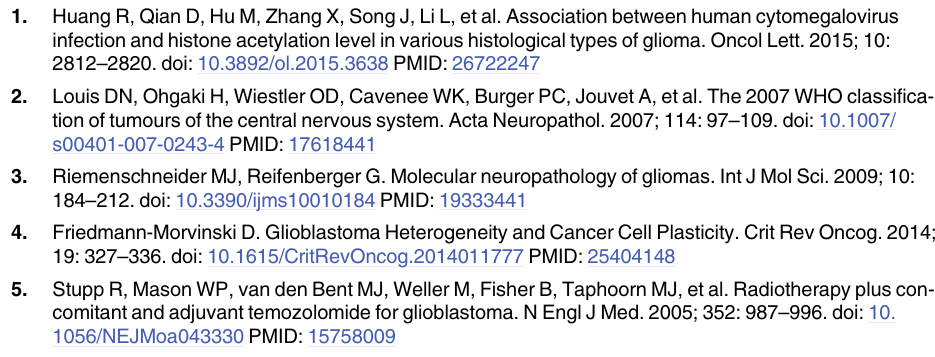
S2 Table. Percentage of positive cells (%), staining intensity (int), final scores, obtained by IHC and ISH, and viral load in astrocytomas (AST), oligodendrogliomas (ODG) and non- tumoral brain